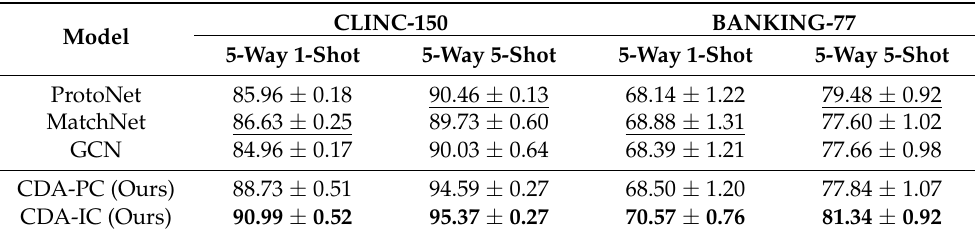
Table 2. Overall performance in terms of accuracy (%) and 95% confidence interval on the test set for two types of meta tasks. The results produced by the best performer in each column are boldfaced. The results produced by the best baseline are